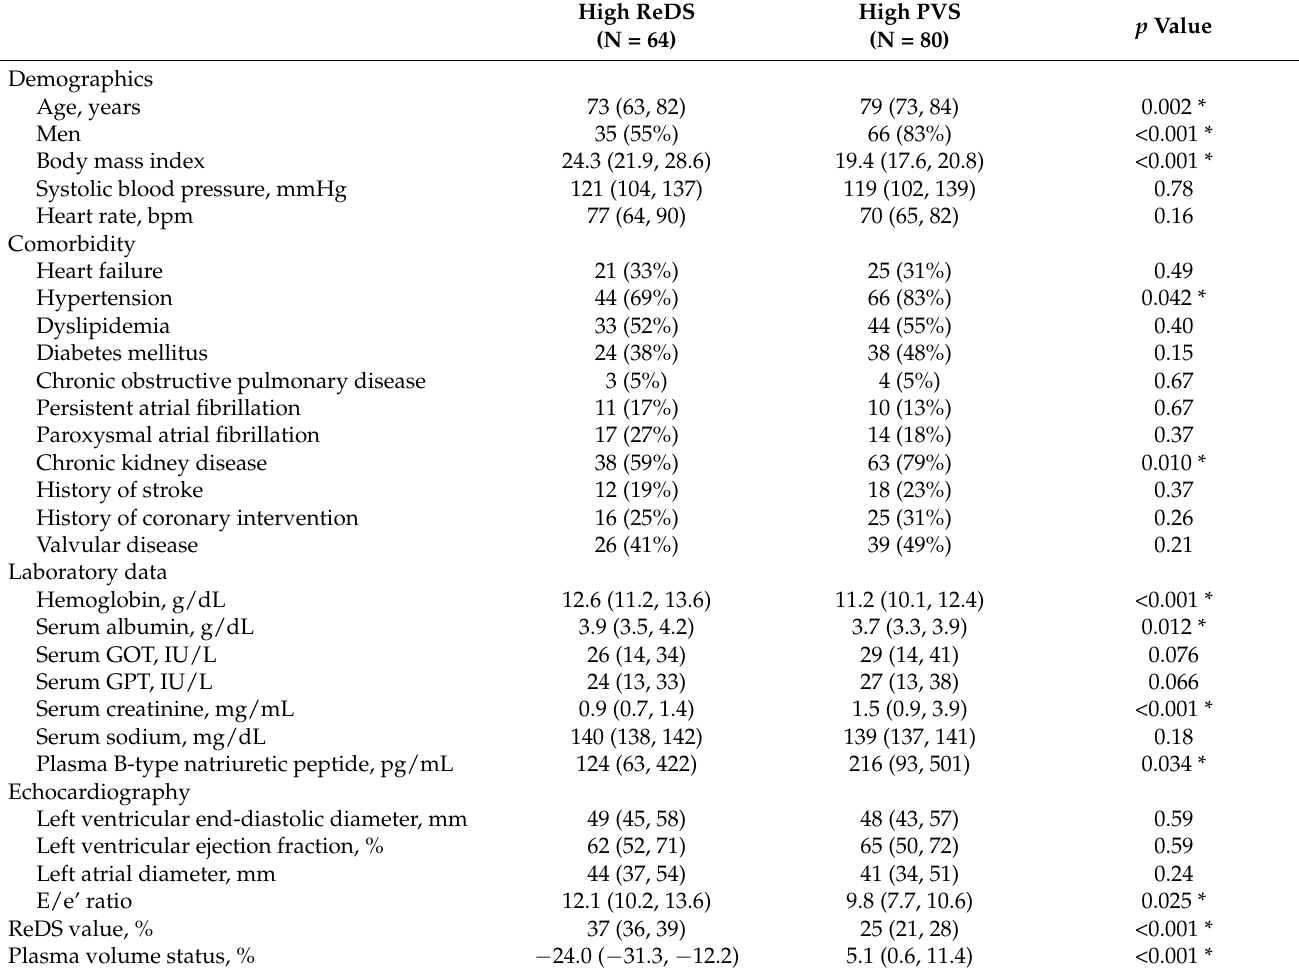
Table 2. Comparison between high ReDS group and high PVS group. High ReDS